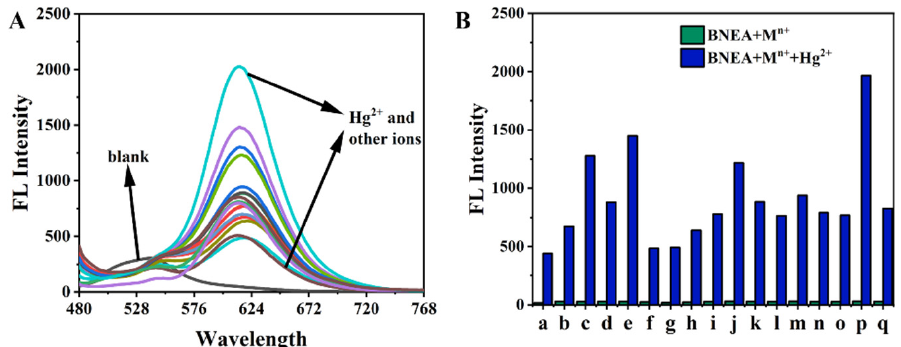
Figure 9. ( A ) Fluorescence spectrum and ( B ) bar graphs of maximum fluorescence inten- sity (a = blank, b = K + , c = Ca 2+ , d = NH 4+ , e = Mn 2+ , f = Cr 3+ , g = Cu 2+ , h = Cu + , i = Pb 2+ , j = Fe 2+ , k = Ni 2+ , l = Cd 2+ , m = Co 2+ , n = Al 3+ , o = Ba 2+ , p = Na + , q = Ag + ) of BNEA anti-interference experiment for mercury ions response performance ( λ ex = 450 nm, [BNEA] = 10 μ M).